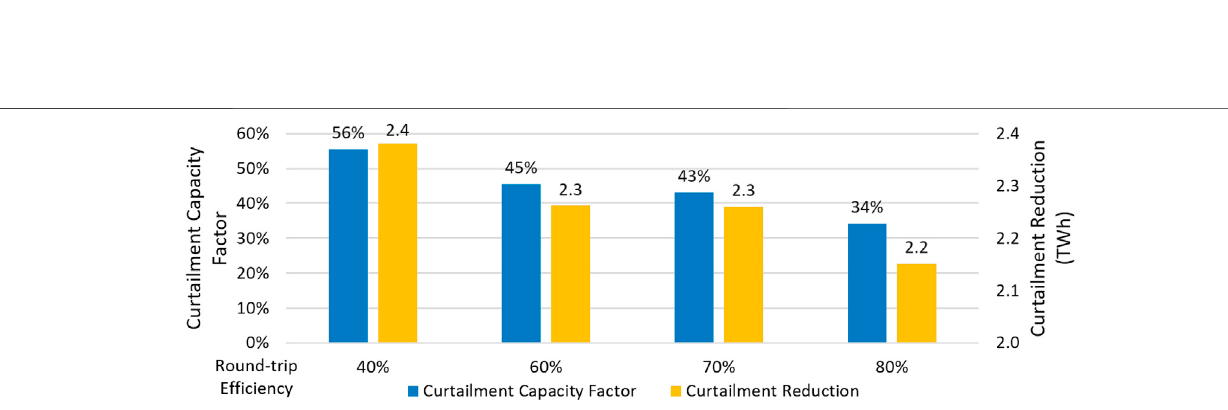
Frontiers in Energy Research |